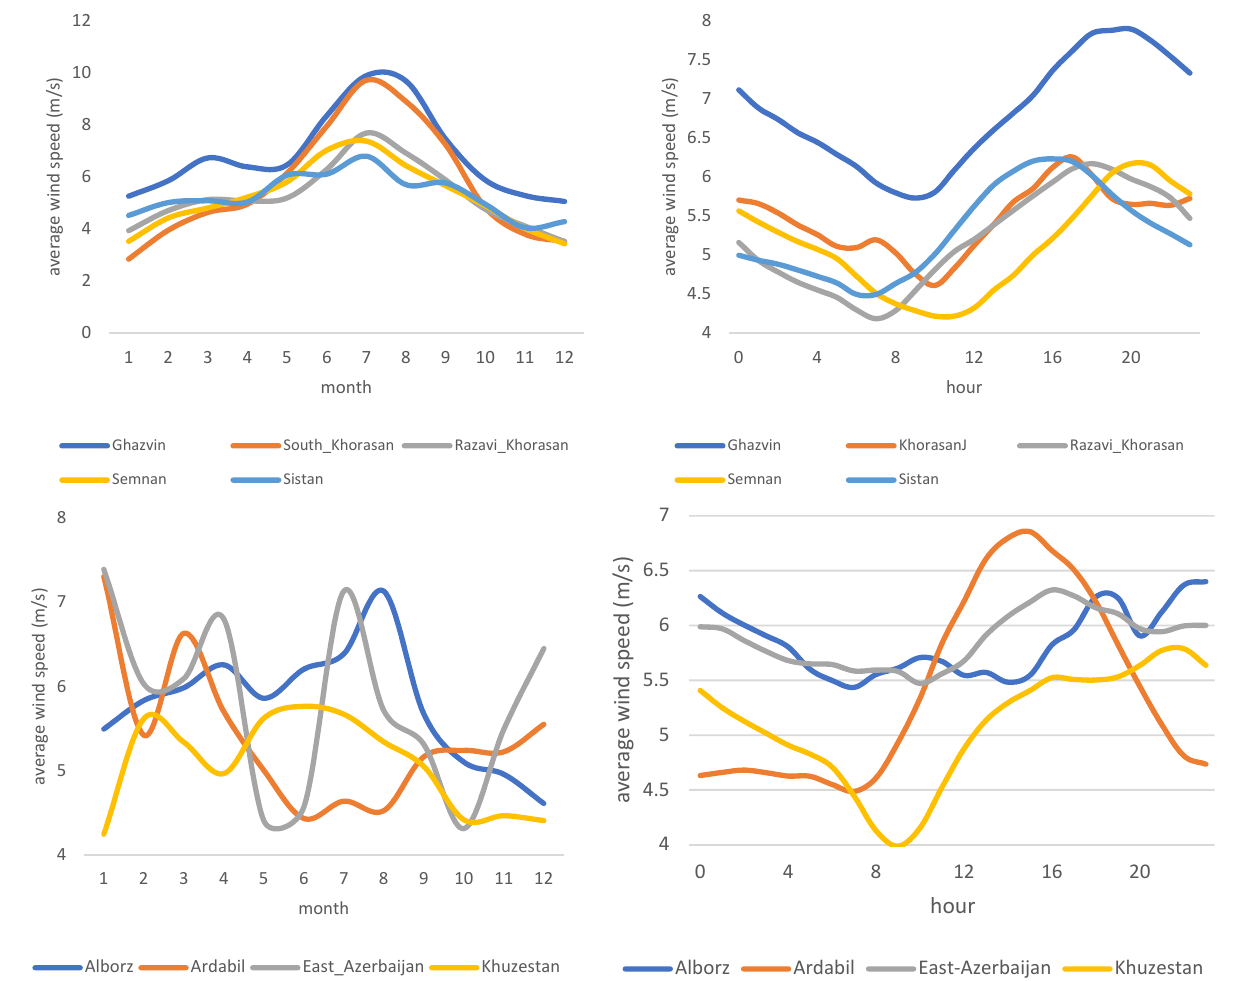
Figure 4. Diurnal and seasonal wind speed variation for Iranian provinces with average annual wind speed larger than 5 m/s.